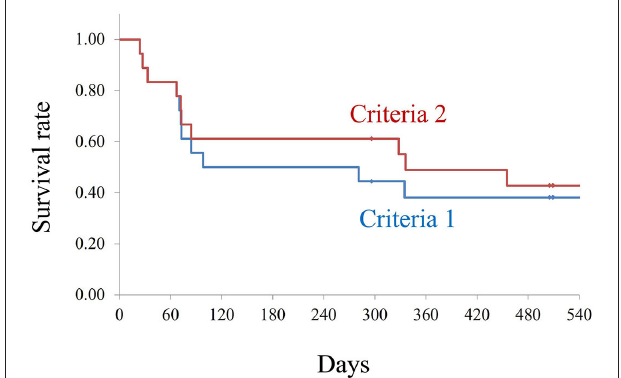
FIGURE 1 | Kaplan–Meier survival analysis for both the criteria. Criteria 1: Number of antiglaucoma medications similar or less than the preoperative number, no additional glaucoma surgery, and introcular pressure (IOP) increase of less than 20% compared with pre-microincision vitreous surgery (pre-MIVS) IOP. Criteria 2: Number of antiglaucoma medications similar or less than the preoperative number, no additional glaucoma surgery, and IOP increase of < 30% compared with pre-MIVS IOP. The log-rank test did not show any statistically significant differences between the two criteria ( P =